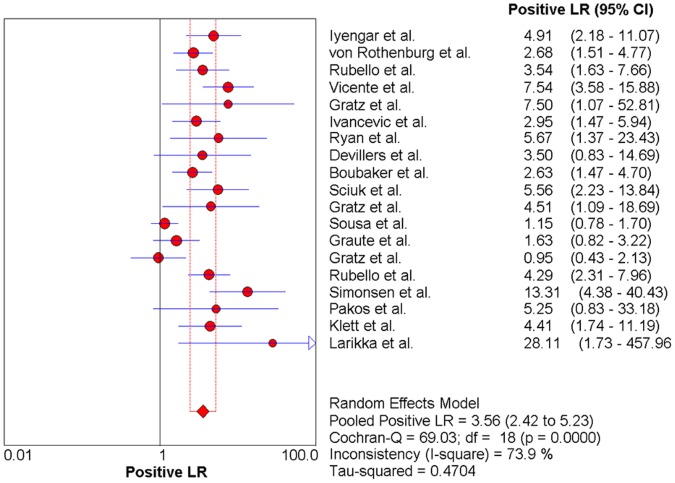
Forest plot for the positive likelihood ratio (PLR) of anti-granulocyte scintigraphy with 99mTc-monoclonal antibodies to diagnose periprosthetic joint infections (PJI).PLR (positive likelihood ratio)  =  3.56 (95% CI, 2.42-5.23).